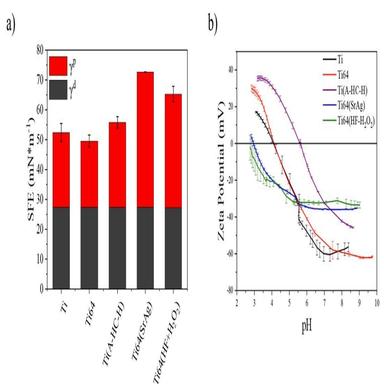
a) total surface free energy of the different surfaces (whole bars) and their respective dispersive (dark grey bars)) and polar components (red bars); b) zeta potential titration curves of the samples.